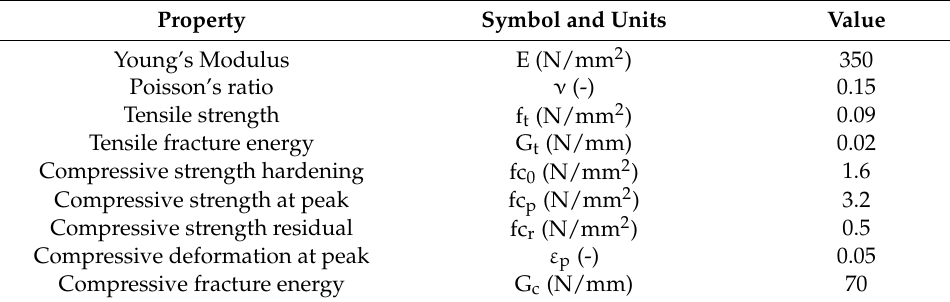
Table 2. Mortar material parameter.